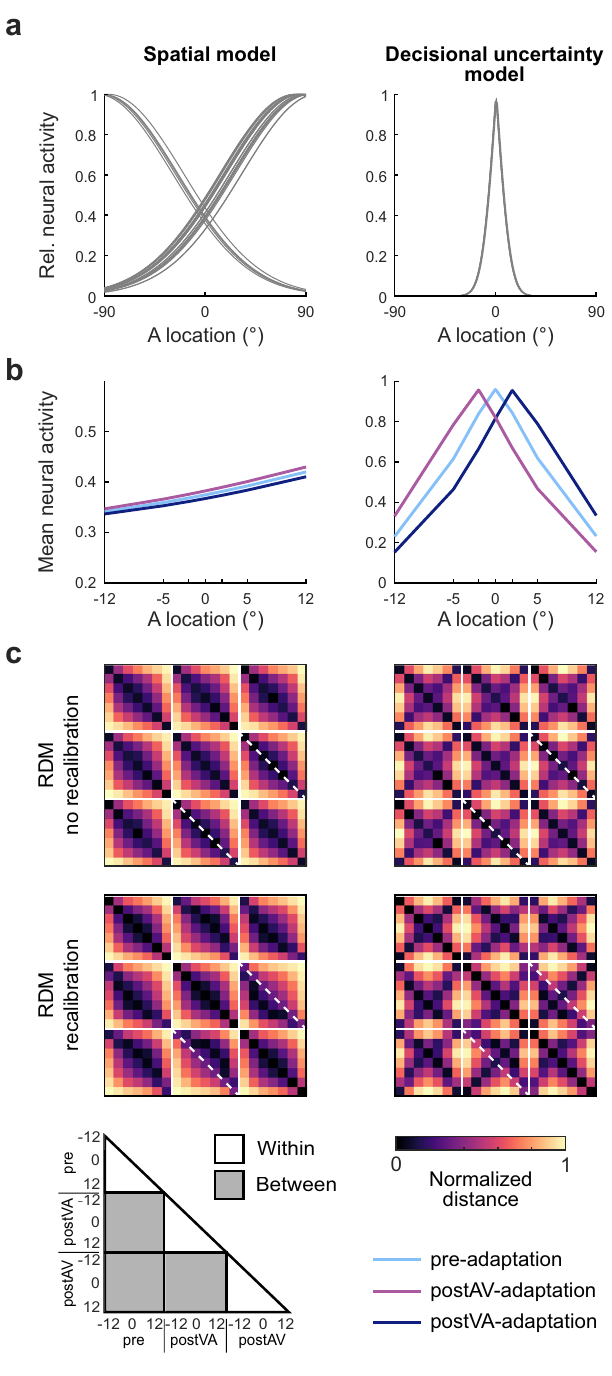
Pattern component modelling is a relatively recent methodo- logical approach that, similar to related multivariate analysis approaches (e.g. multivariate multiple regression or multivariate analysis of variance) models multivariate observations (i.e. multi- voxel activity patterns) by a set of explanatory variables (e.g.